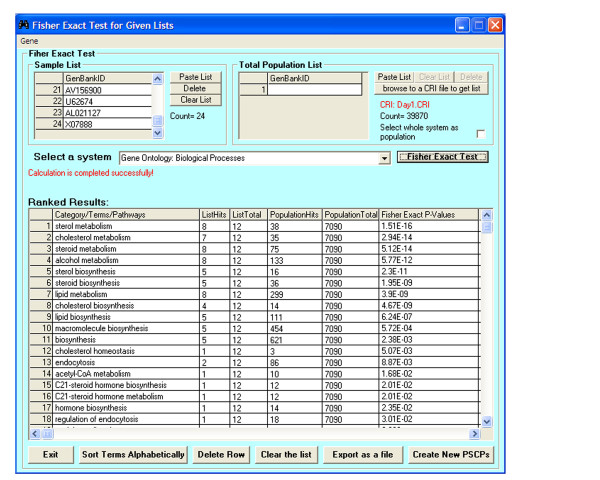
The <Fisher's exact test for Given Lists> window. The gene list derived from pattern extraction in Fig. 6 was copied and pasted into this window. The gene list from Day 1 CRI file was chosen as the total population list. GO: Biological Process was used as the system for Fisher's exact test. The computation results are ranked based on the p-values of each category (i.e. GO term) of the system. The less p-value, the higher the category ranks.